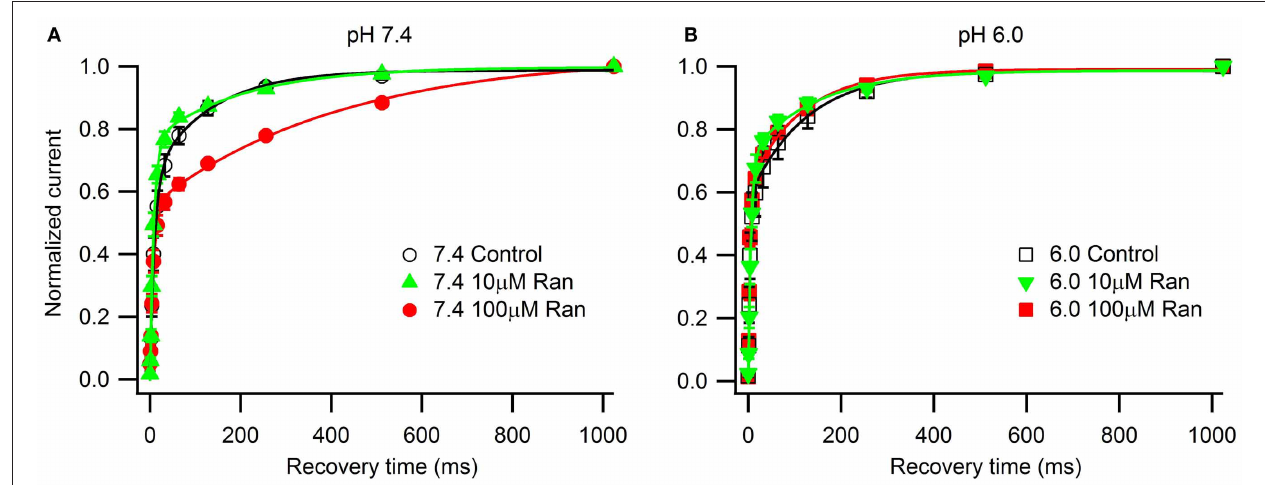
FIGURE 3 | Fastinactivationrecovery at − 130mV. Fast inactivation was inducedbya 500msconditioningpulse to − 10mV.Cells were then hyperpolarizedto − 130mVfor0–1000msandcurrentmeasuredwitha − 10mV test pulse was plottedasa functionof recoverypulseduration andfittedwith a